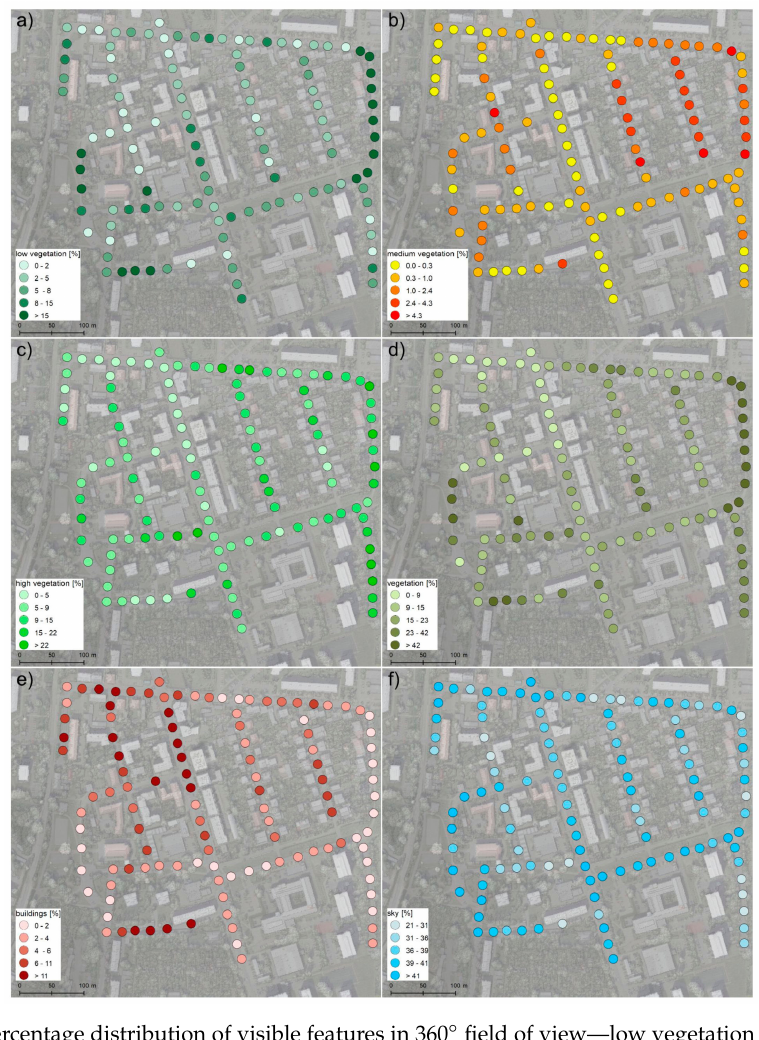
Figure 8. Percentage distribution of visible features in 360 ◦ field of view—low vegetation ( a ), medium vegetation ( b ), high vegetation ( c ), total vegetation ( d ), buildings ( e ), sky ( f ).